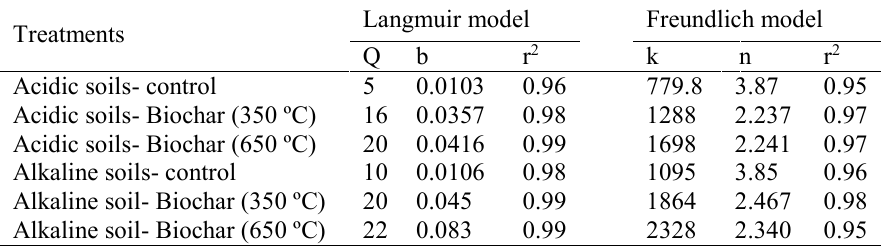
Table 5. The adsorption isotherm models and its coefficients Treatments